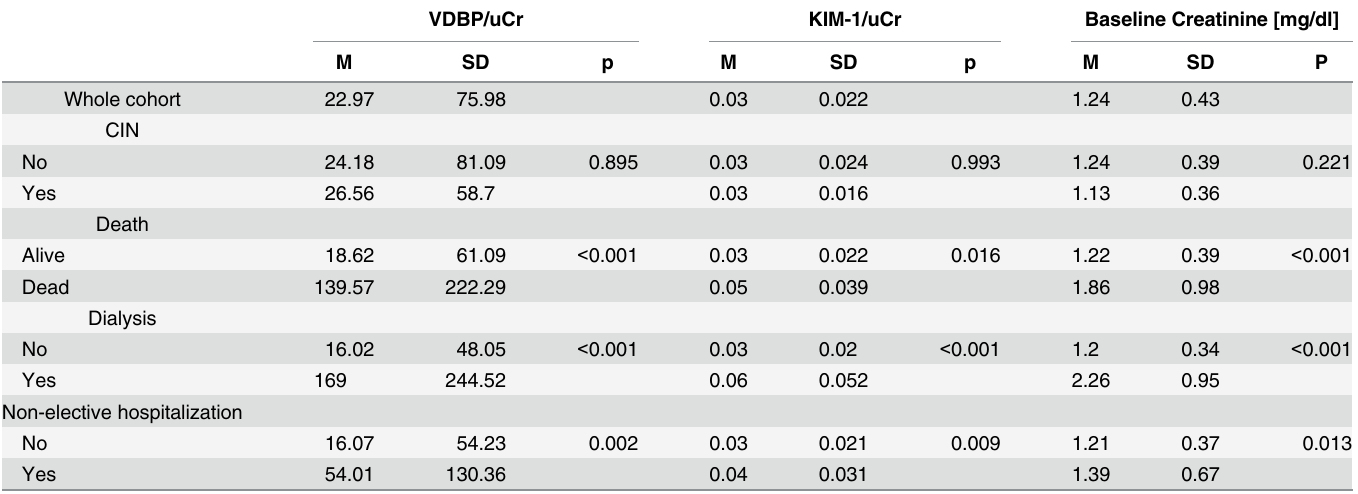
Table 4. VDBP/uCr, KIM-1/uCr 24 hrs after CM injection and baseline creatinine comparison in patients with and without complications. VDBP: vitamin D binding protein, KIM-1: kidney injury molecule 1, uCr: urinary creatinine, CIN: contrast induced nephropathy, MARE: major adverse renal event,